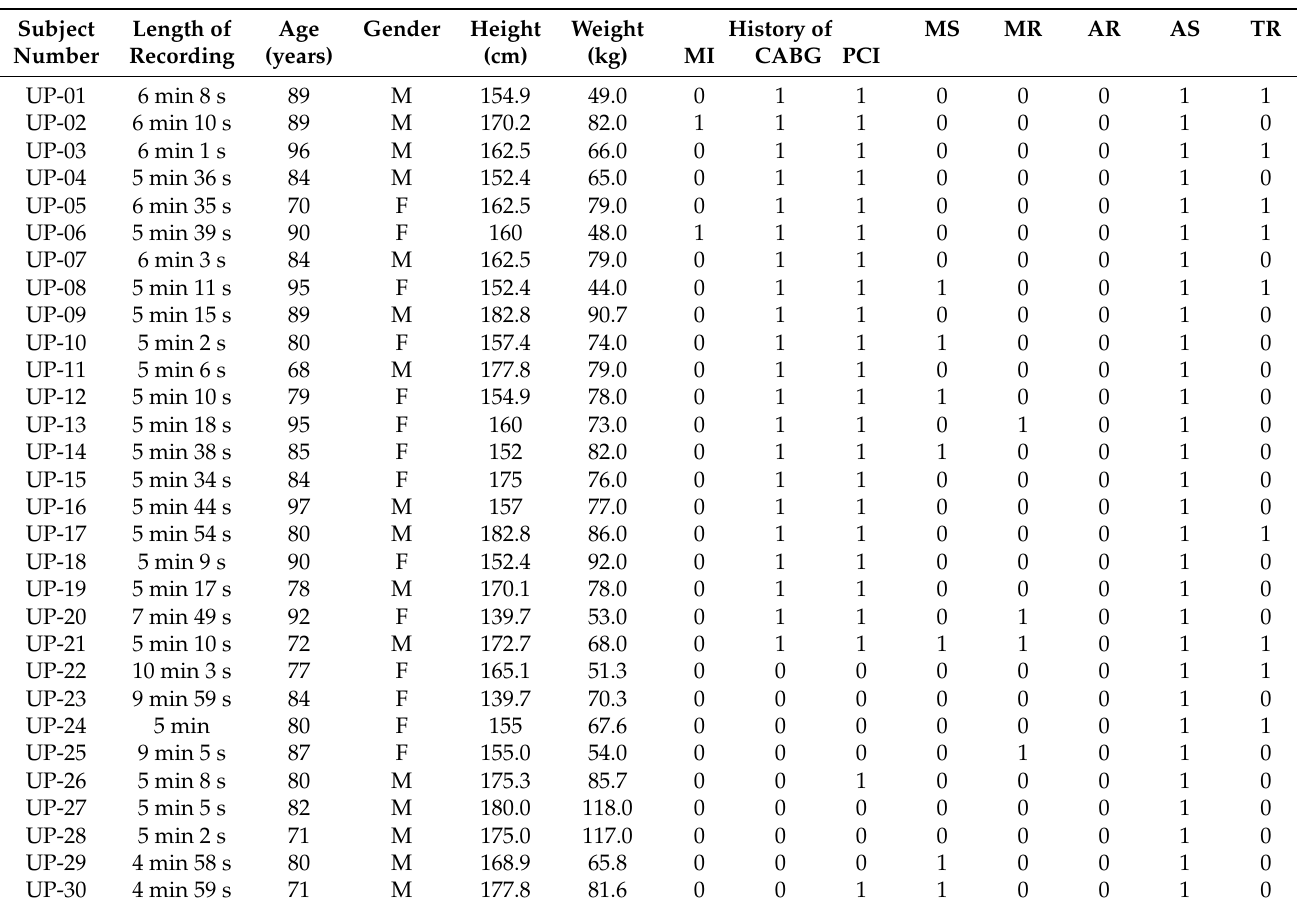
Table A2. Recording description in “An Open-access Database for the Evaluation of Cardio- mechanical Signals from Patients with Valvular Heart Diseases”